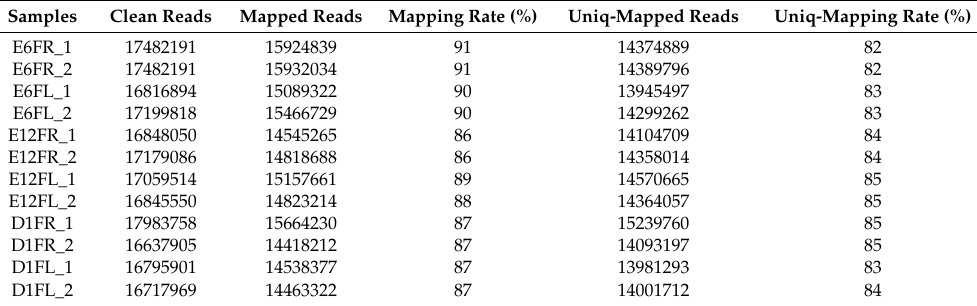
Table 1. Summary of RNA-seq reads mapping to reference genome.